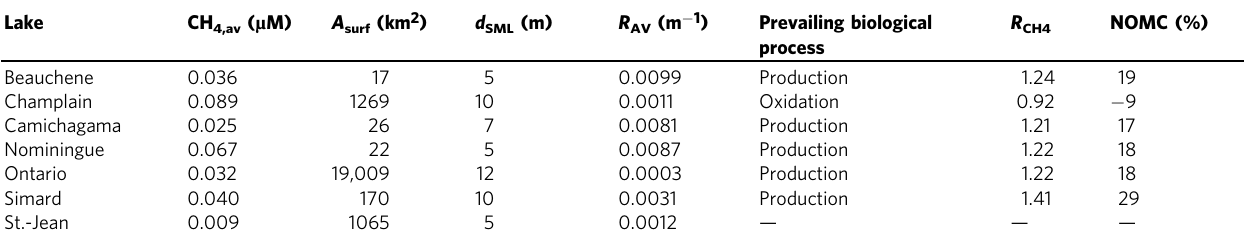
Table 2 Analysis of data of DelSontro et al. 7 for the 7 lakes investigated by Günthel et al. 5 .